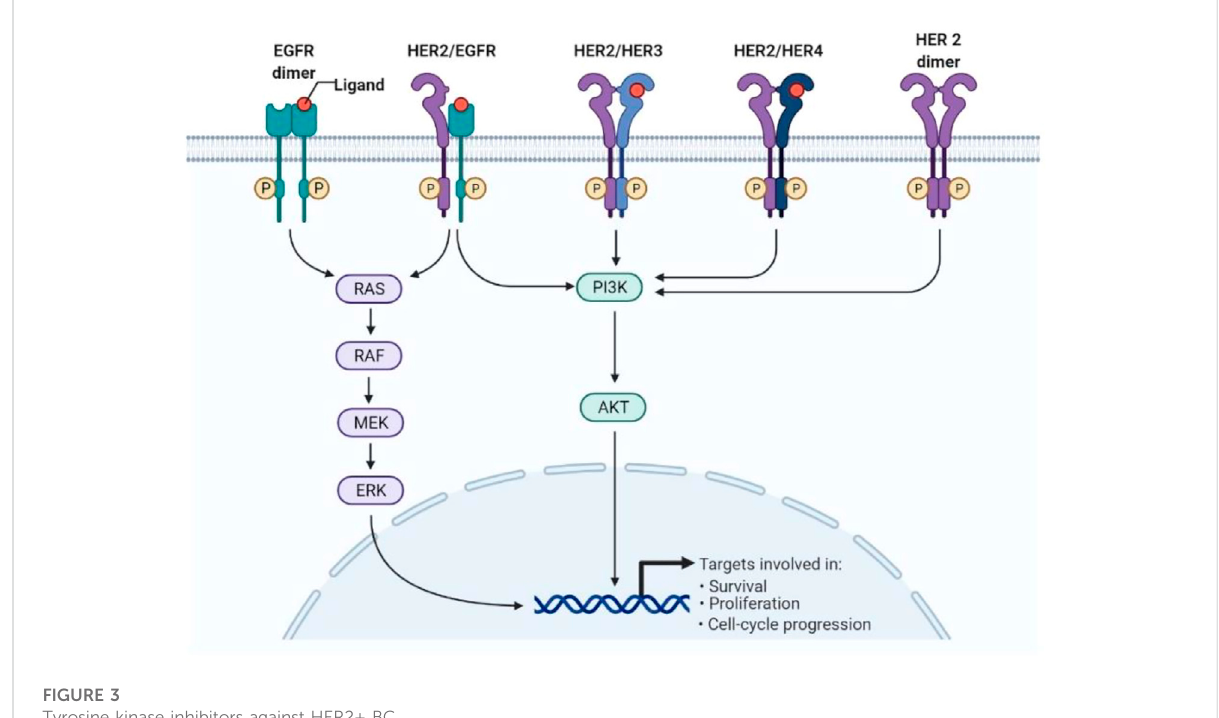
Signaling pathways in HER2+ breast